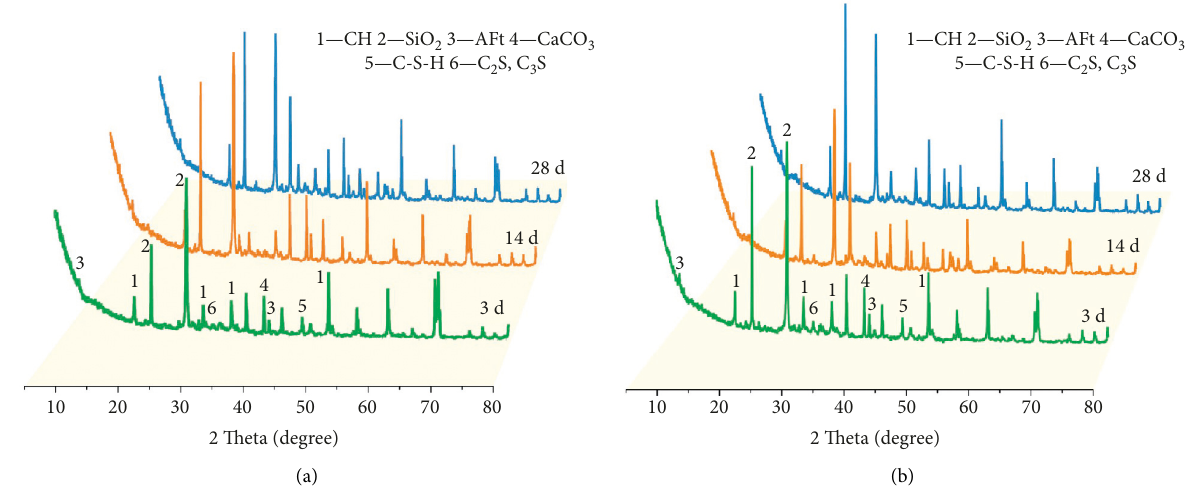
Figure 13: XRD results at different ages: (a) S-Non; (b)